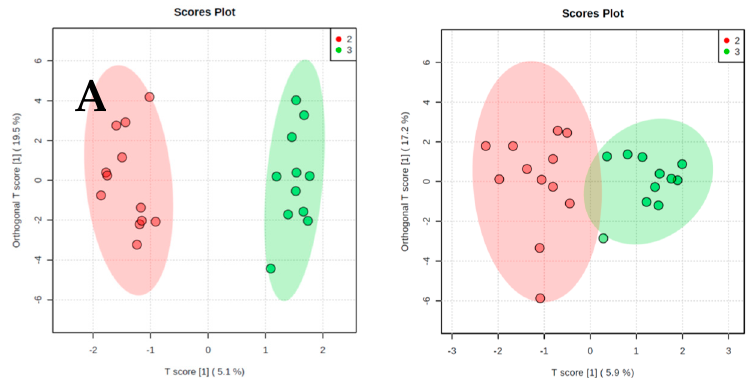
Figure 3. Orthogonal projections to latent structures discriminant analysis. ( A ) Pre-cachectic patients and non-cachectic patients. Urinary Metabolites only. ( B ) Pre-cachectic patients and non-cachectic patients. Urinary metabolites and information on fat and muscle area from CT scans.